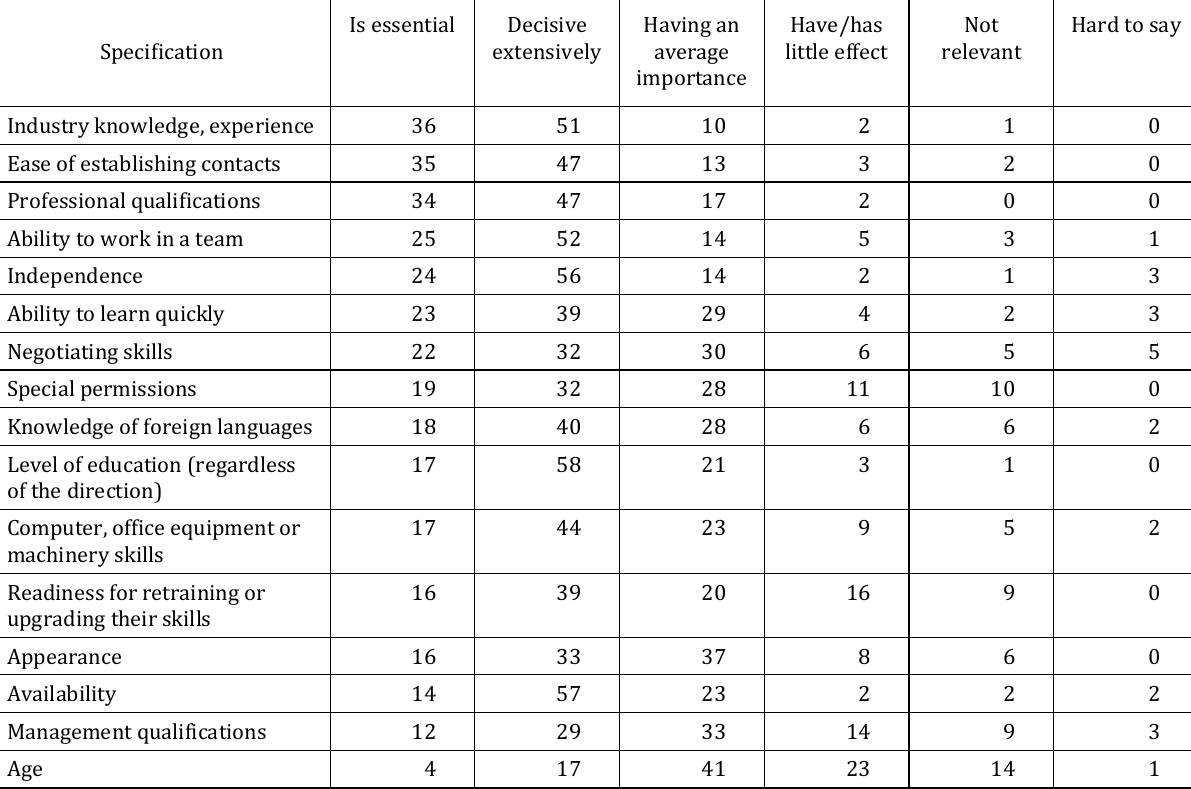
Table 1. Which criteria are important in your company when hiring employees (in%) Is Specification